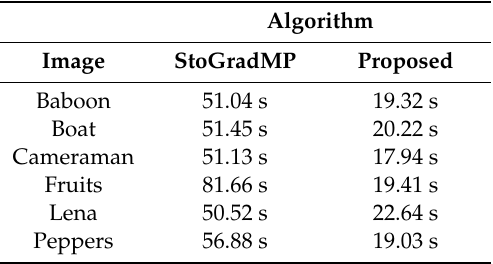
Table 2. Comparison of the average runtimes of the StoGradMP and proposed algorithms for the di ff erent test